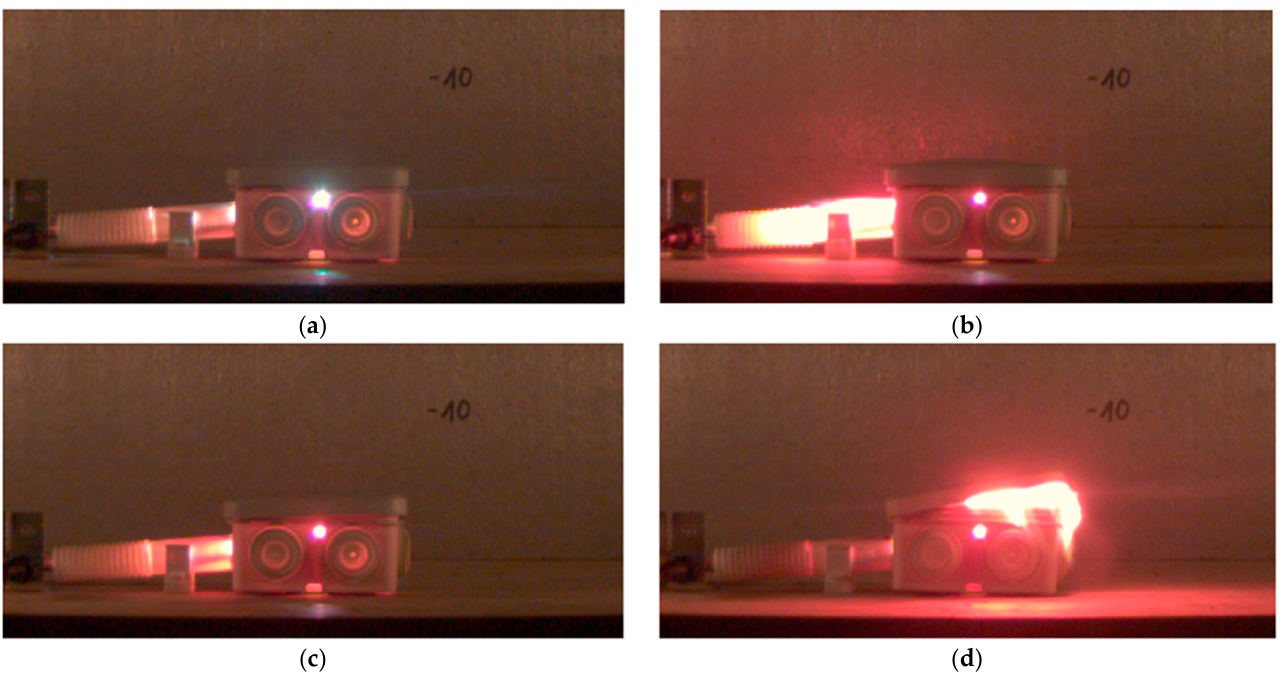
Figure 7. Evolution and product release of plasma and emergency arc products within the elements of a non-hermetic installation junction box ( a ) t = 0.5 ms; ( b ) t = 1.5 ms; ( c ) t = 2.5 ms; ( d ) t = 3.5 ms ( I m = 1250 A, U = 400 V, Cu-Cu electrodes).